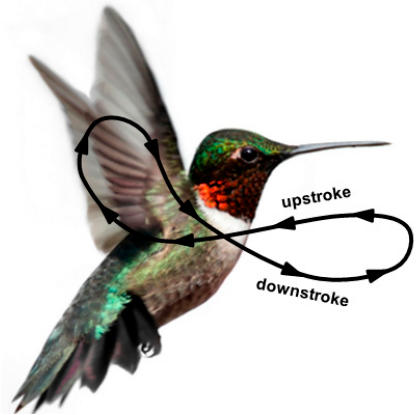
Figure 1. The figure eight pattern during a single flapping period.